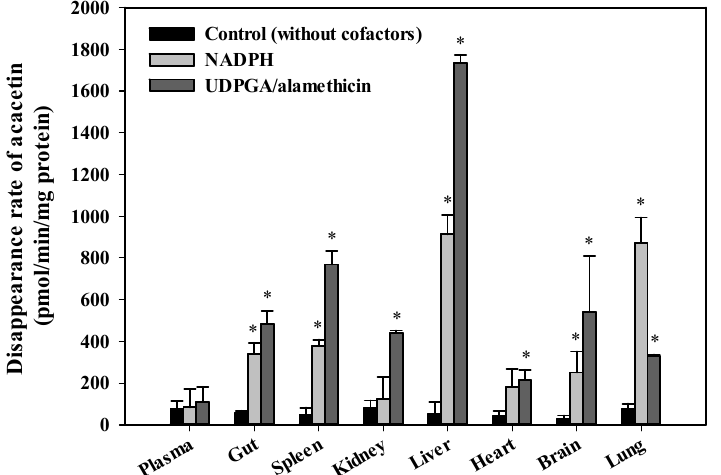
Figure 5. Disappearance rates of acacetin in rat plasma and various tissue S9 fractions in the presence of nicotinamide adenine dinucleotide phosphate (NADPH), (NADPH) and uridine diphosphate glucuronic acid (UDPGA)/alamethicin. The rectangular bars and error bars represent the means and standard deviations, respectively ( n = 3). The asterisk indicates statistical significance when compared to the control group (* p < 0.05).